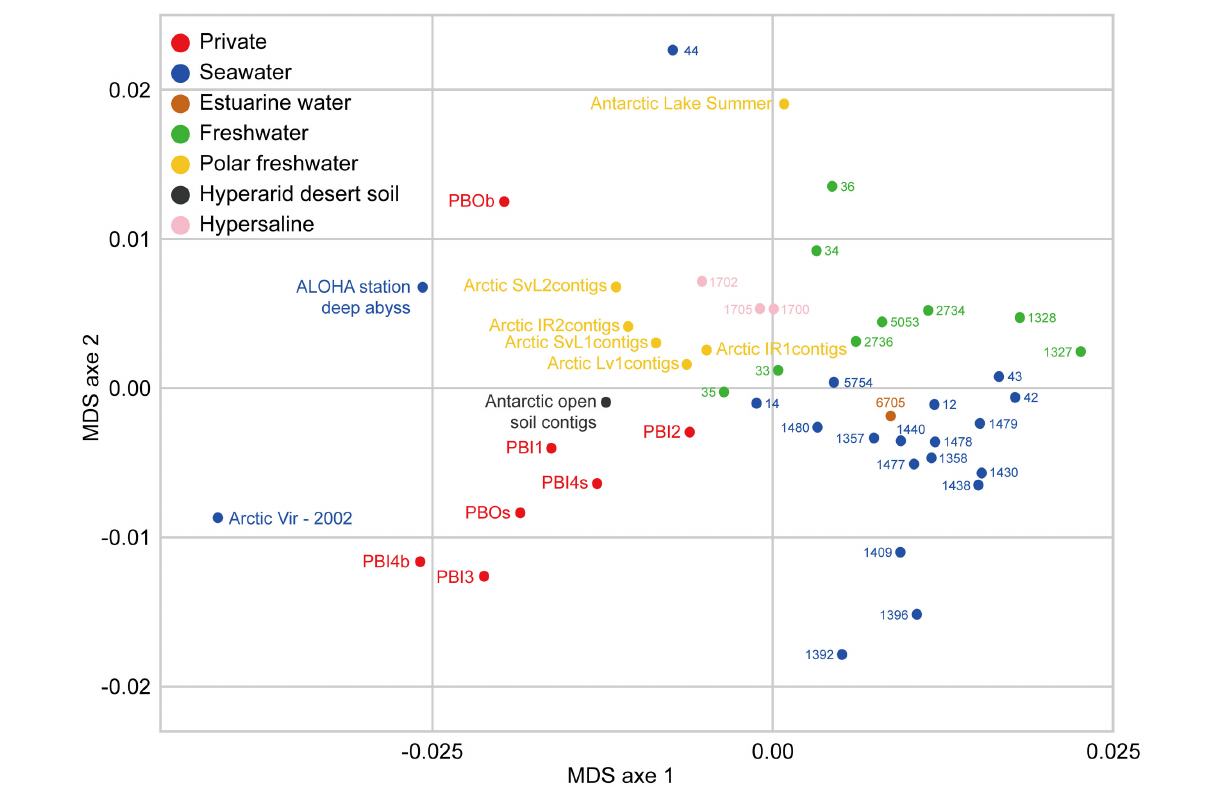
FIGURE 7 | Comparison between DNA viromes in the Prydz Bay and other environmental DNA viromes based on k-mer frequency bias (tetranucleotides). Forty environmental DNA viromes available on MetaVir2 were selected from different kinds of environments, including seawater (20), freshwater (15), hypersaline (3), estuarine water (1), and Antarctic hyperarid desert soil (1). The number represented the project ID. The details of the selected viromes are shown in Table S3 . Different colors refer to different environments showed in the legend on the top